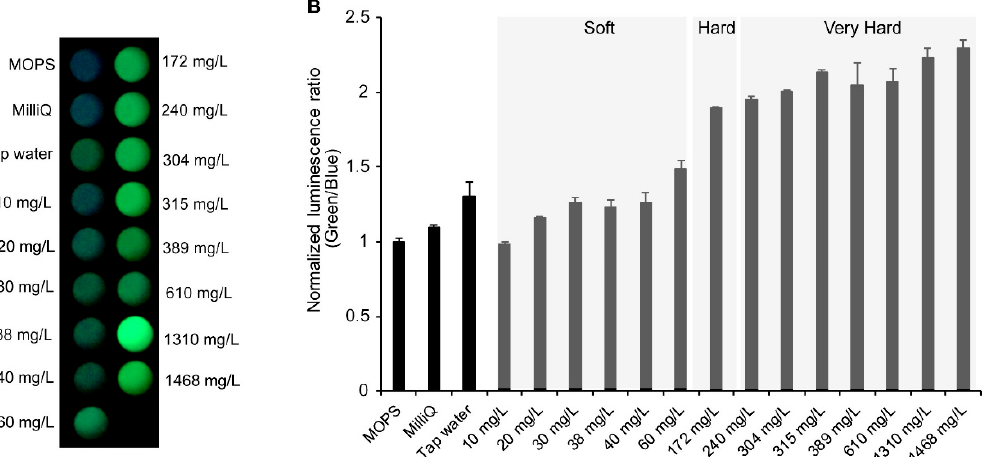
Figure 4. Detection of WH-dependent bioluminescence color change using a smartphone camera. LOTUS-W and water samples were reacted on a 96-well plate with a substrate, and images were taken using a smartphone camera. The image from each sample area ( A ) was separated into red-green-blue channels, and the intensity ratio of green to blue was calculated ( B ). From the results of the commercially available drinking water with di ff erent WH, the scale of WH of the tap water was assessed. Milli-Q water was used as the control. Each bioluminescence emission ratio was normalized to the count without additional water (MOPS) ( n = 3). The classifications of WH are indicated in gray boxes.